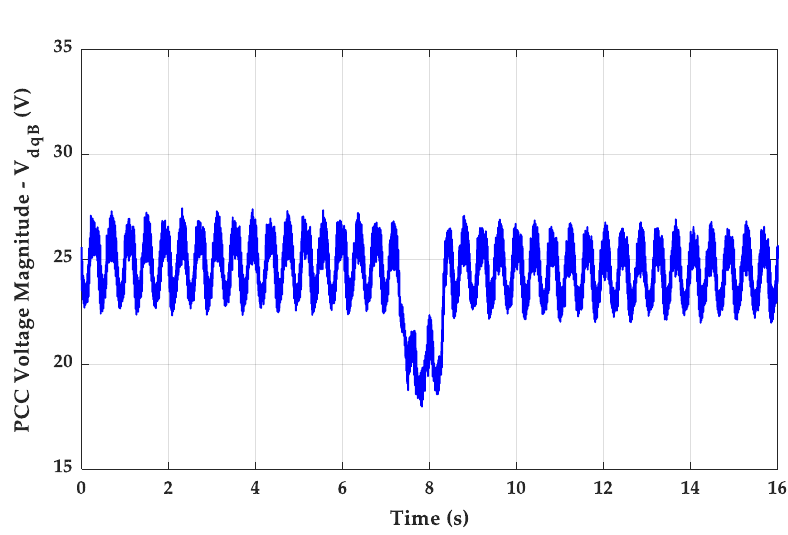
Figure 14. Voltage magnitude response at the PCC (Experiment 2).